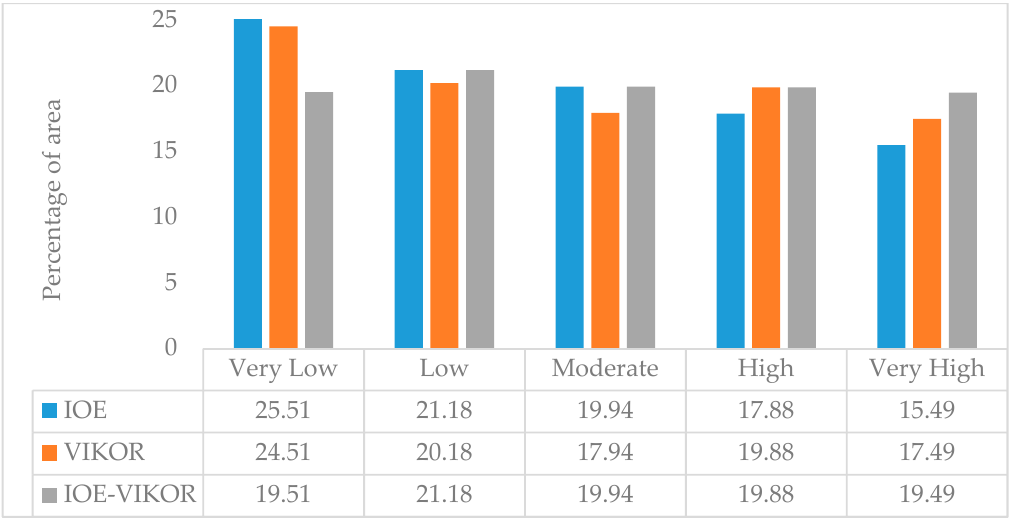
ff erent models.